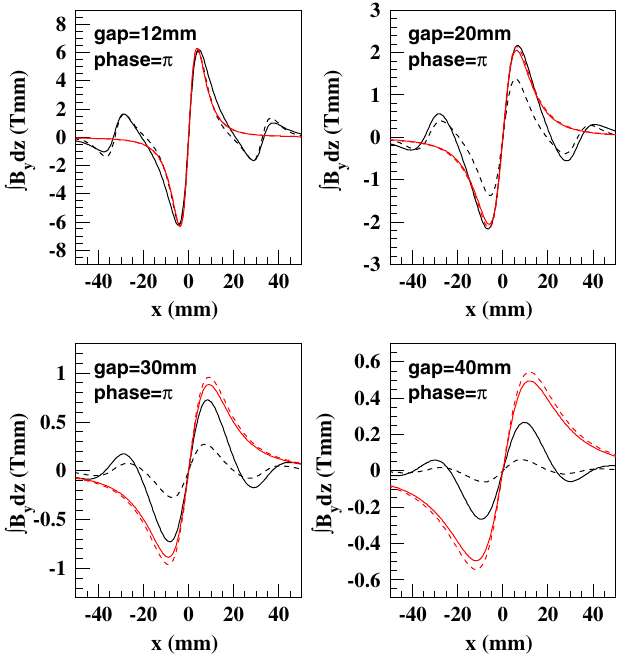
FIG. 13. Dynamic multipoles (black) and L shims (red) for the UE112 (solid) and a UE56 with the same length (dashed) in the midplane for different gaps. Dynamic multipoles and shims of the UE56 are scaled with a constant factor for better comparison. The shim configuration (number of standard L -shim quadruples and shim shape) has been optimized for the UE112 at a gap of 20 mm.